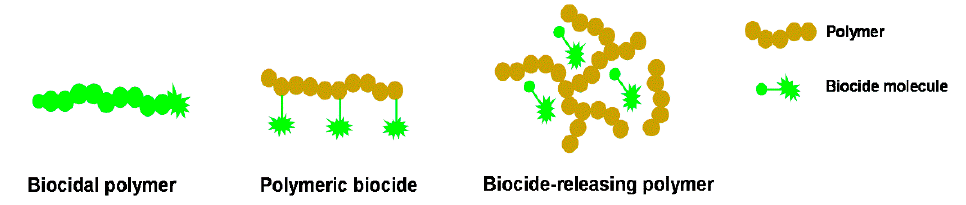
Figure 1. Schematic representation of the different types of antimicrobial polymeric systems (adapted from [8]).